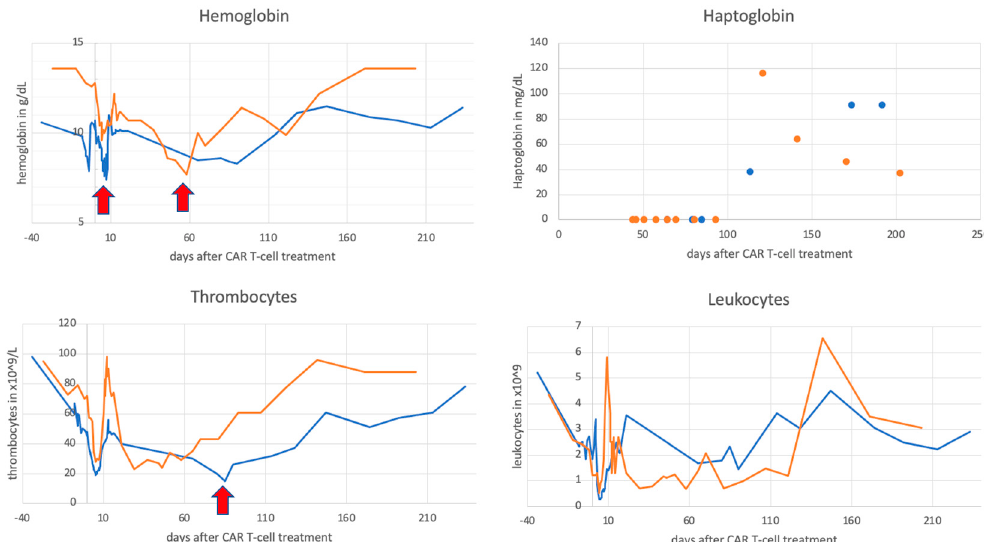
Figure 1. Course of hemoglobin, haptoglobin, leukocytes, thrombocytes over time. Blue = patient A, orange = patient B, arrows indicate blood transfusions (erythrocytes and thrombocytes, respectively).